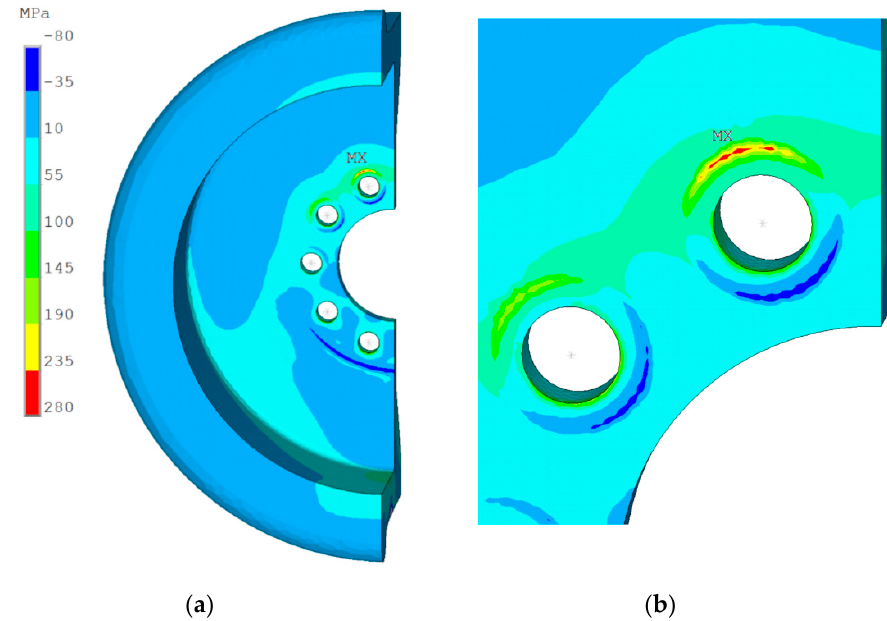
Figure 11. Maximum principal stress distribution for the optimal rail wheel geometry made of 42CrMo4 steel. ( a ) View of the entire model; ( b ) view of the stress concentration